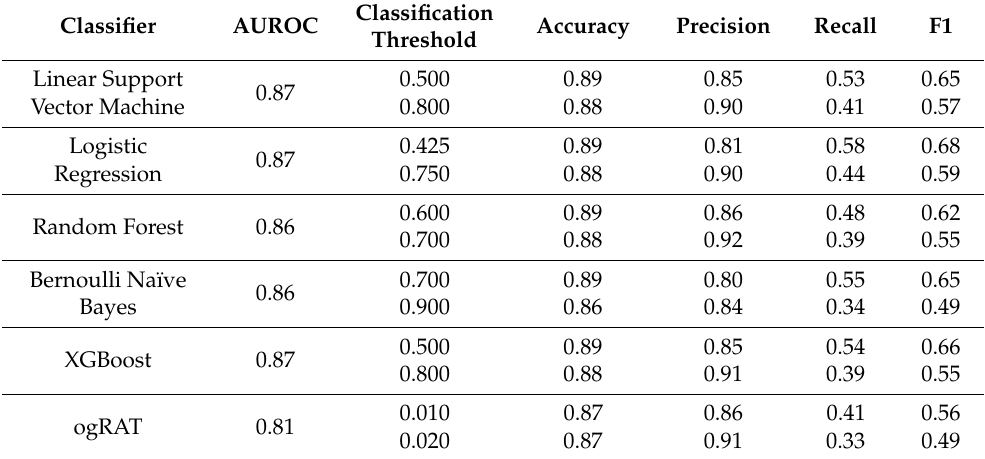
Table 2. Performances of machine-learning-based probabilistic classifiers on test dataset in compari- son with oesophago-gastric cancer risk-assessment tool (ogRAT) matrix (performance calculated on same test set) for prediction of oesophago-gastric cancer incidence.